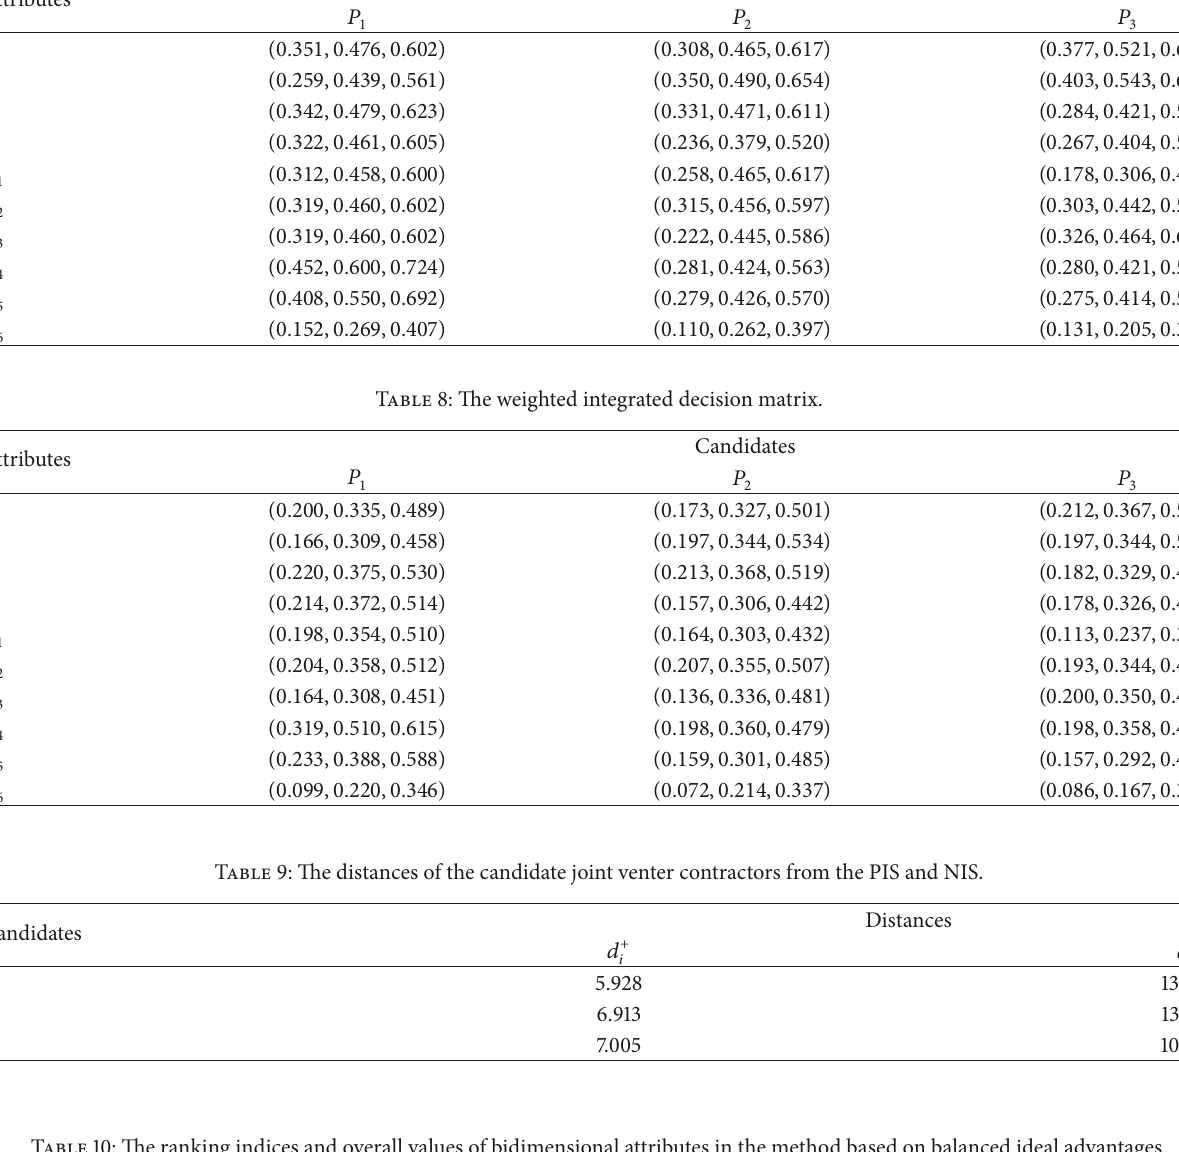
Table 10: The ranking indices and overall values of bidimensional attributes in the method based on balanced ideal